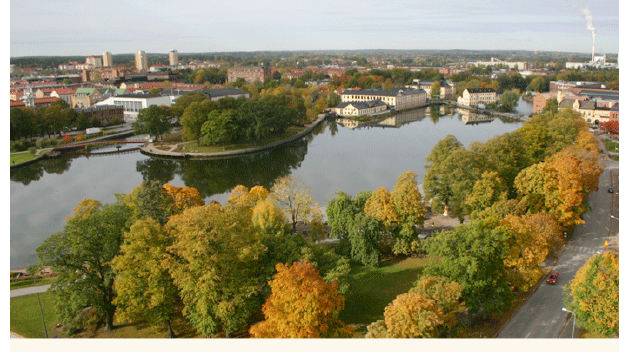
Fig. 2 . The City of Eskilstuna. The Eskilstuna River flows through the city, connecting the two lakes, Hjälmaren and Mälaren. The river as a trading route contributed to making this an attractive area for settlements, for over 3000 years. From the 16th century the river became a source of power for the metal industry, for which the City of Eskilstuna became a center. The industry declined after structural changes in the 1970s, and lately, a hotel, restaurants, an art museum, and a sports arena have moved into the old industrial buildings, some of which are shown in this photo. Photo by Göran Jonsson, Eskilstuna